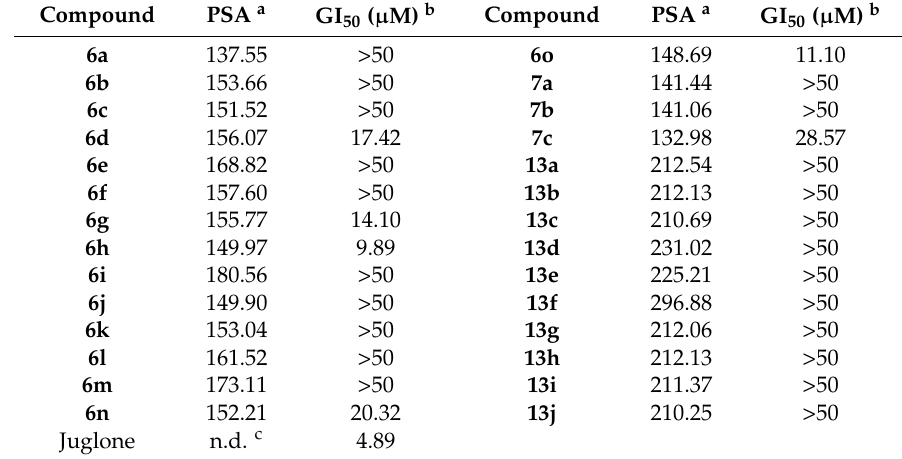
Table 3. The antiproliferative activities against prostate cancer PC-3 cells and calculated PSA of target